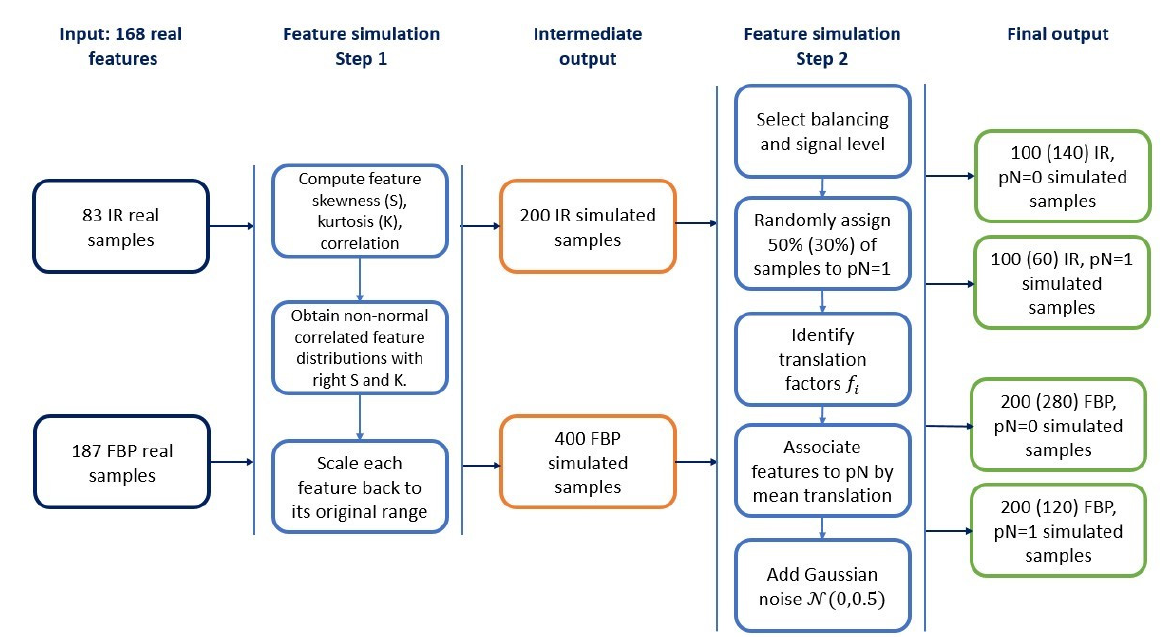
Figure 1. Simulation procedure flow chart. Input are two sets of 168 real features, derived from CT (Computer Tomography) images reconstructed with the Filtered Back Projection (FBP) and Iterative Reconstructions (IR) algorithm, respectively (left column). The first step of the procedure (second column) describes how to obtain simulated features not associated to the outcome, which represents an intermediate output (middle column). The second part of the procedure (fourth column) associates samples and features to the outcome variable and provides as the final output, different sets of 168 features (right column). Cardinality of those sets depends on algorithm and sample balancing: sizes for balanced cases are reported, with sizes for unbalanced cases in parenthesis.